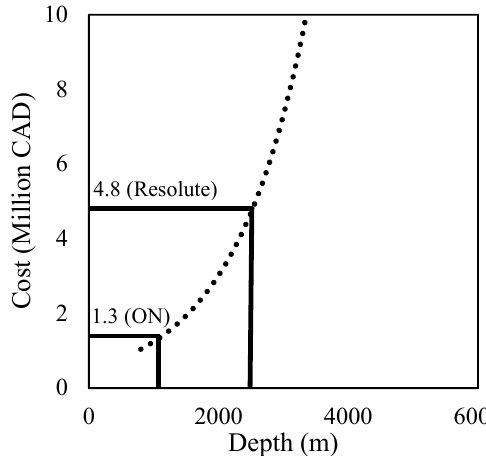
Figure 5. Drilling cost vs. depth, modified from Heidinger [100]. Table 11. Summary of generator costs [95].